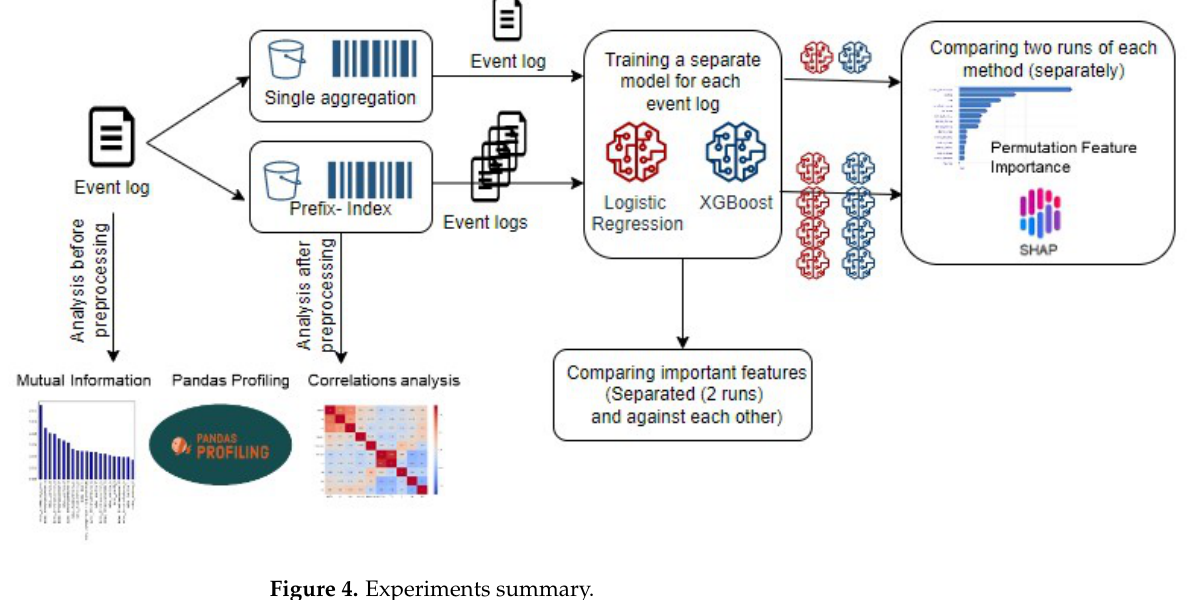
Figure 4. Experiments